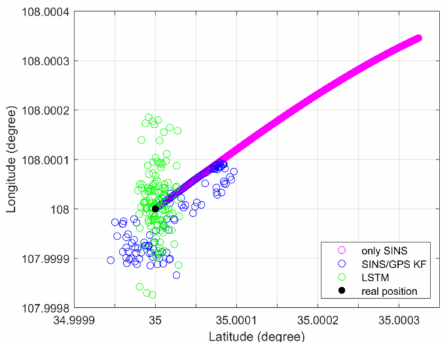
Figure 5. Static position information of